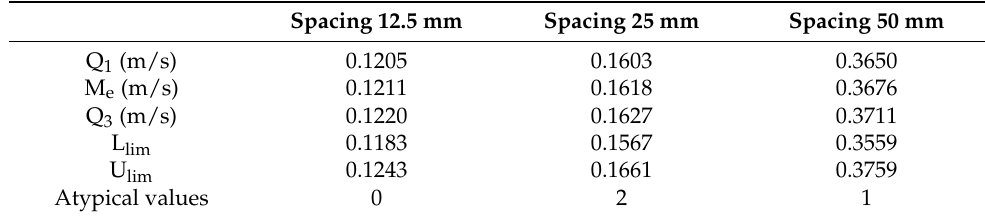
Figure 10. Boxplots with maximum speeds. Table 2. Results of the boxplot applied to different point